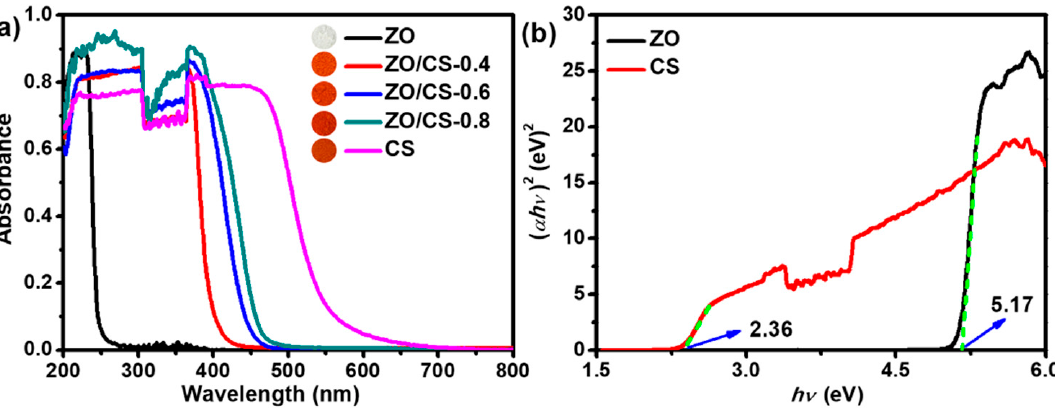
Figure 4. ( a ) UV − vis DRS of ZO, CS, and ZO/CS nanocomposites; ( b ) plots of ( α h ν ) 2 versus energy ( h ν ) for ZO and CS.